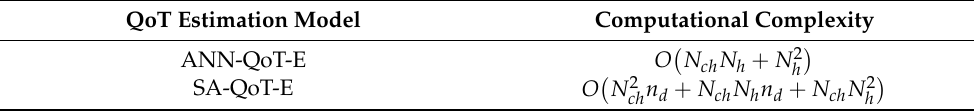
Table 2. Computational complexity of the ANN-QoT-E and the